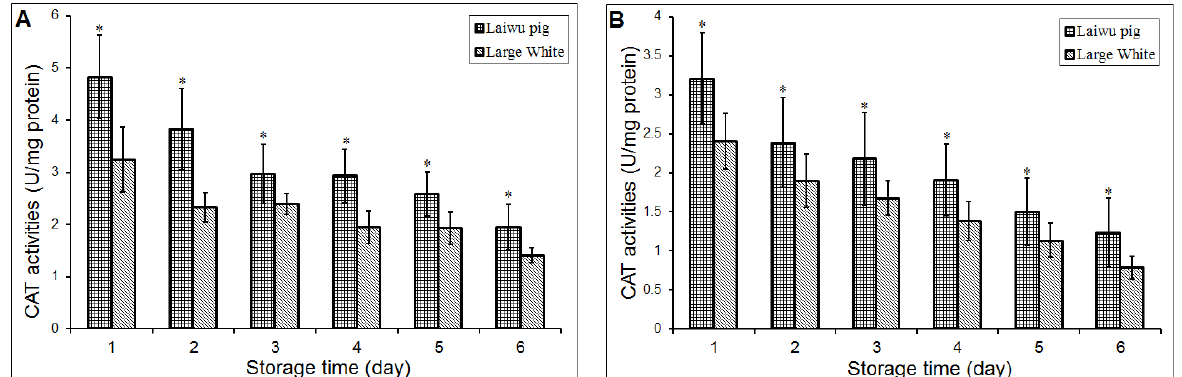
Figure 2. Comparison of muscle CAT activity. The muscle samples of Laiwu pig and Large White pig stored at 4  C (A) and 20  C (B) for 1-6 days. Each value is represented as the means  SEM ( n = 6). Asterisks indicate differences that are statistically significant (*